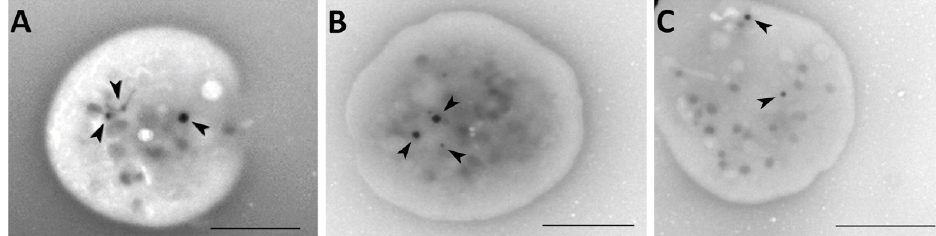
* Values in brackets represent the 95% confidence interval. Abbreviations: Fbg—fibrinogen, Ara—arachidonic acid, ADP—adenosine diphosphate, EDTA—ethylenediaminetetraacetic acid, Trap6—thrombin receptor activator peptide.